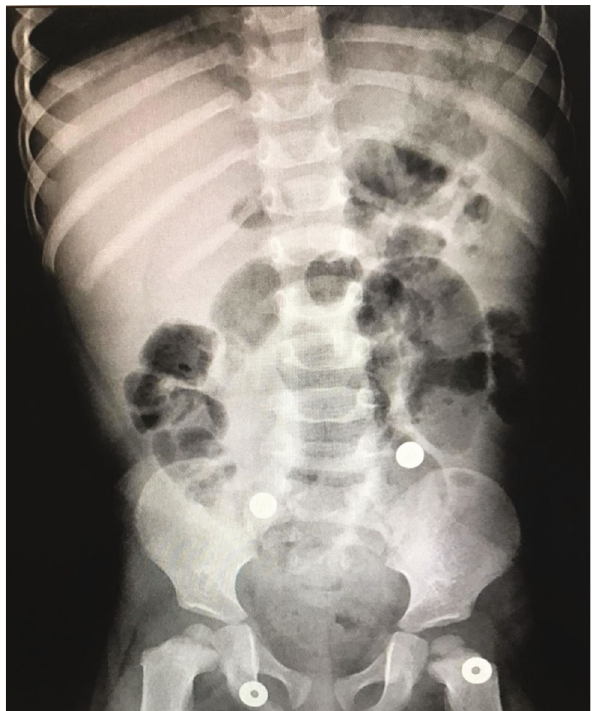
Figure 3: Postoperative abdominal X-ray shows resolution of the foreign body previously found